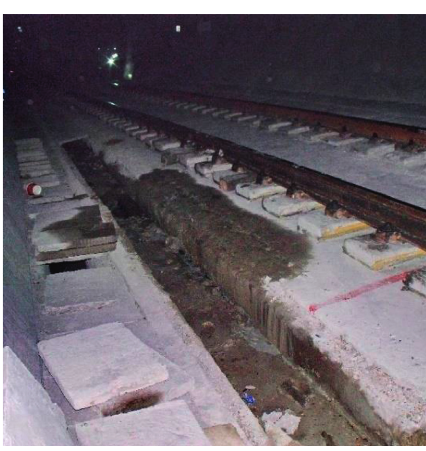
Figure 3: Tunnel frost boiling.